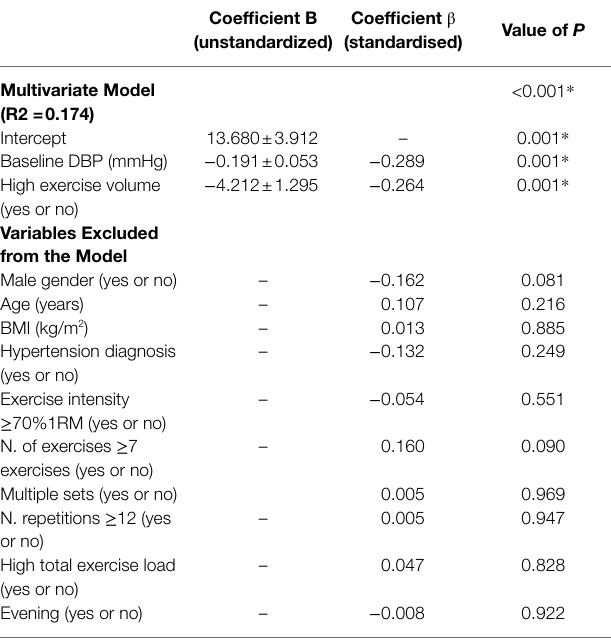
TABLE 4 | Multiple linear regression assessing predictors of post-dynamic resistance exercise hypotension for diastolic blood pressure (DBP). Coefficient B Coefficient β Value of P (unstandardized) (standardised) Multivariate Model (R2 =